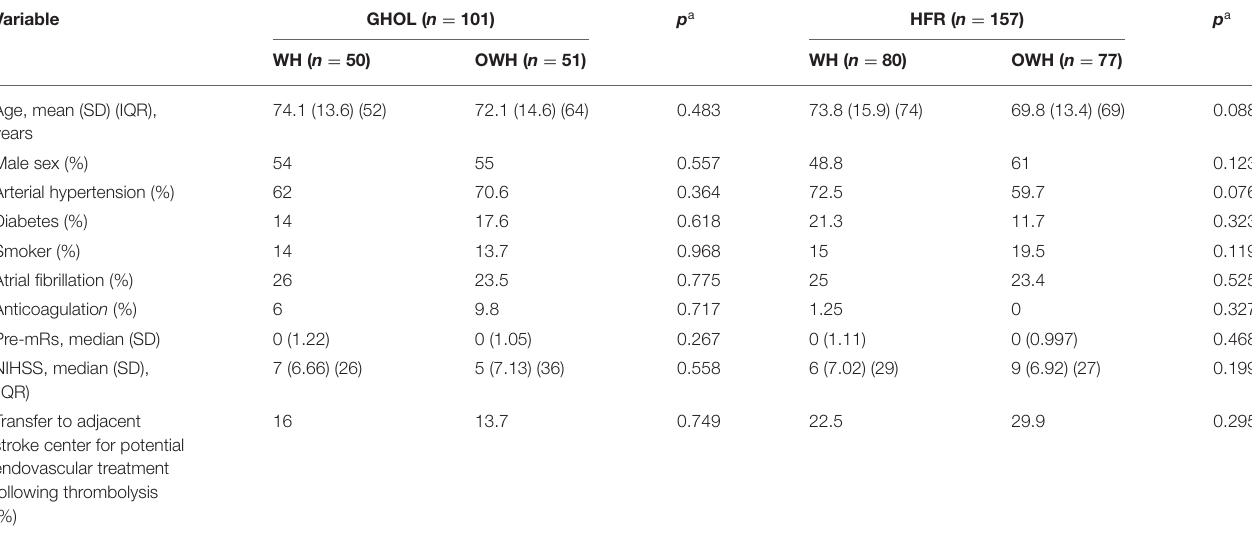
TABLE 2 | Inter-site-specific demographics and clinical characteristics according to admission time.